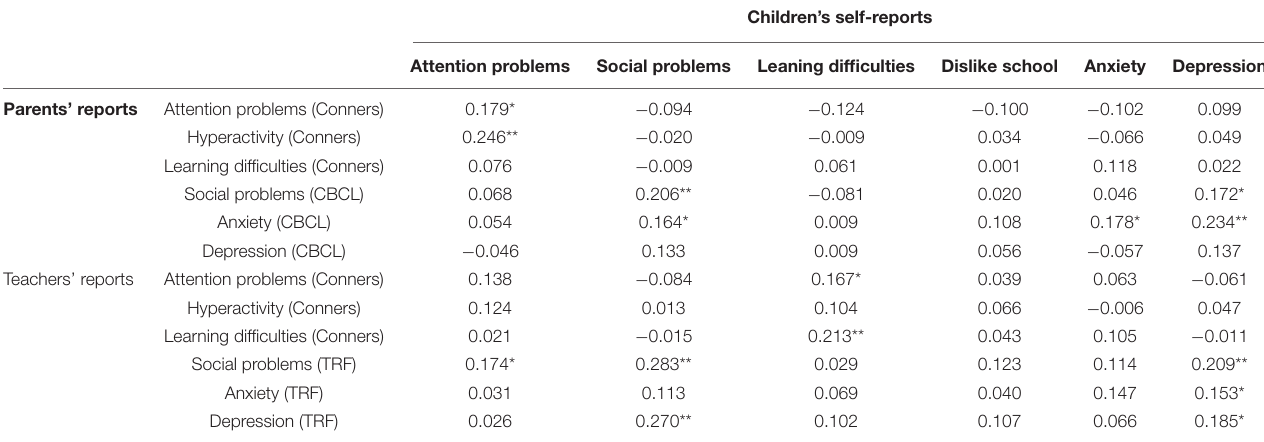
TABLE 2 | Spearman correlations matrix between self-, parent-, and teacher- reports of ADHD-related